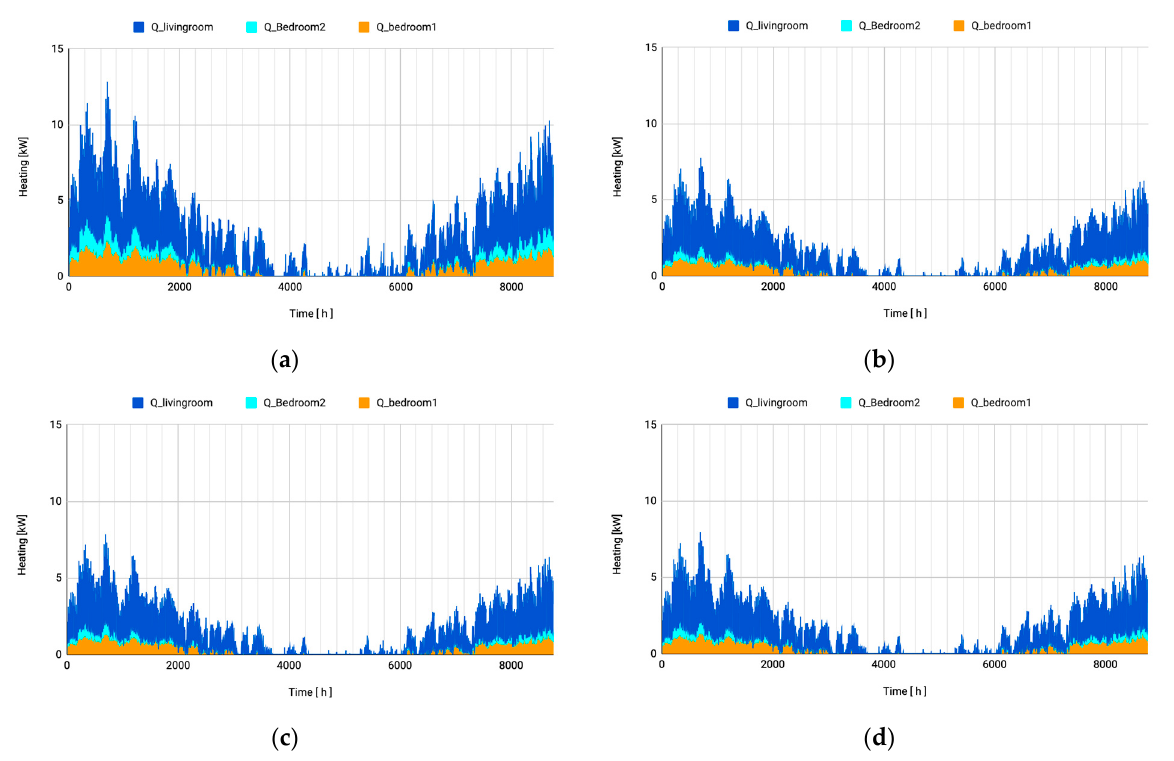
Figure 7. Energy performance simulation (Heating consumption in kWh): ( a ) current state, ( b ) with sheep’s wool, ( c ) with hemp wool, ( d ) with EPS. The simulation is valid for 8760 h of a typical meteorological year.